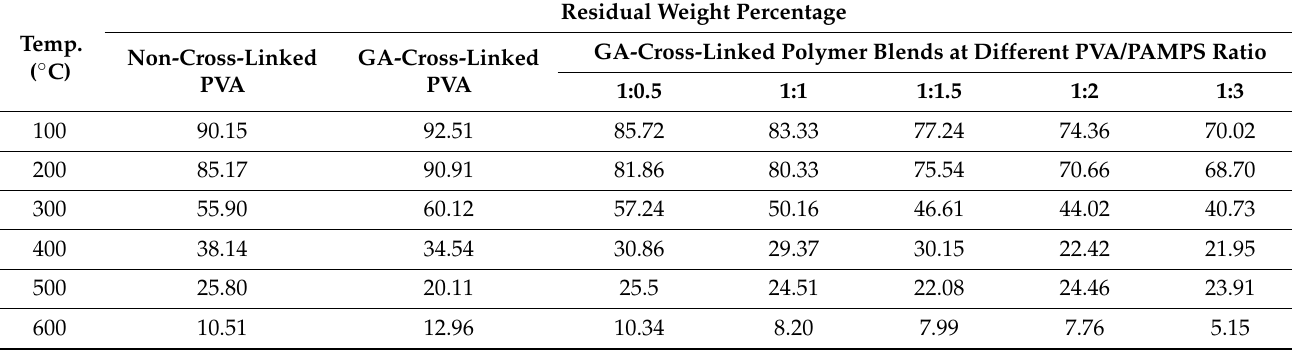
Table 1. Variation of residual weight percentage with temperature in TGA thermograms for non-cross-linked PVA and GA-cross-linked PVA, and PVA/PAMPS blend-based membranes.